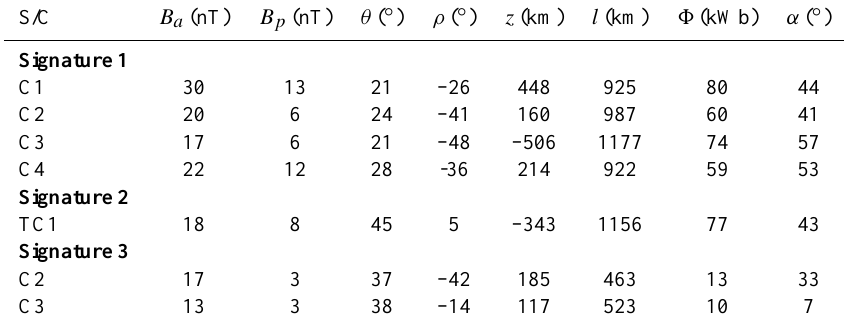
Table 1. Physical parameters returned from the flux rope model fits and the derived magnetic flux through each flux rope. B a and B p are the axial and poloidal fields, respectively; θ is the rotation angle about the model coordinate system x axis; ρ is the rotation angle about the model coordinate system z axis; z is the impact parameter; l the flux rope radius and 8 the magnetic flux through the rope. α is the angle between the flux rope axis returned from MVA and the axis returned from the model fit. Quantities are rounded to the nearest nT, ◦ , km or kWb as appropriate. A positive (negative) impact parameter denotes that the spacecraft passed above (below) the flux rope axis. S/C B a (nT) B p (nT) θ ( ◦ ) ρ ( ◦